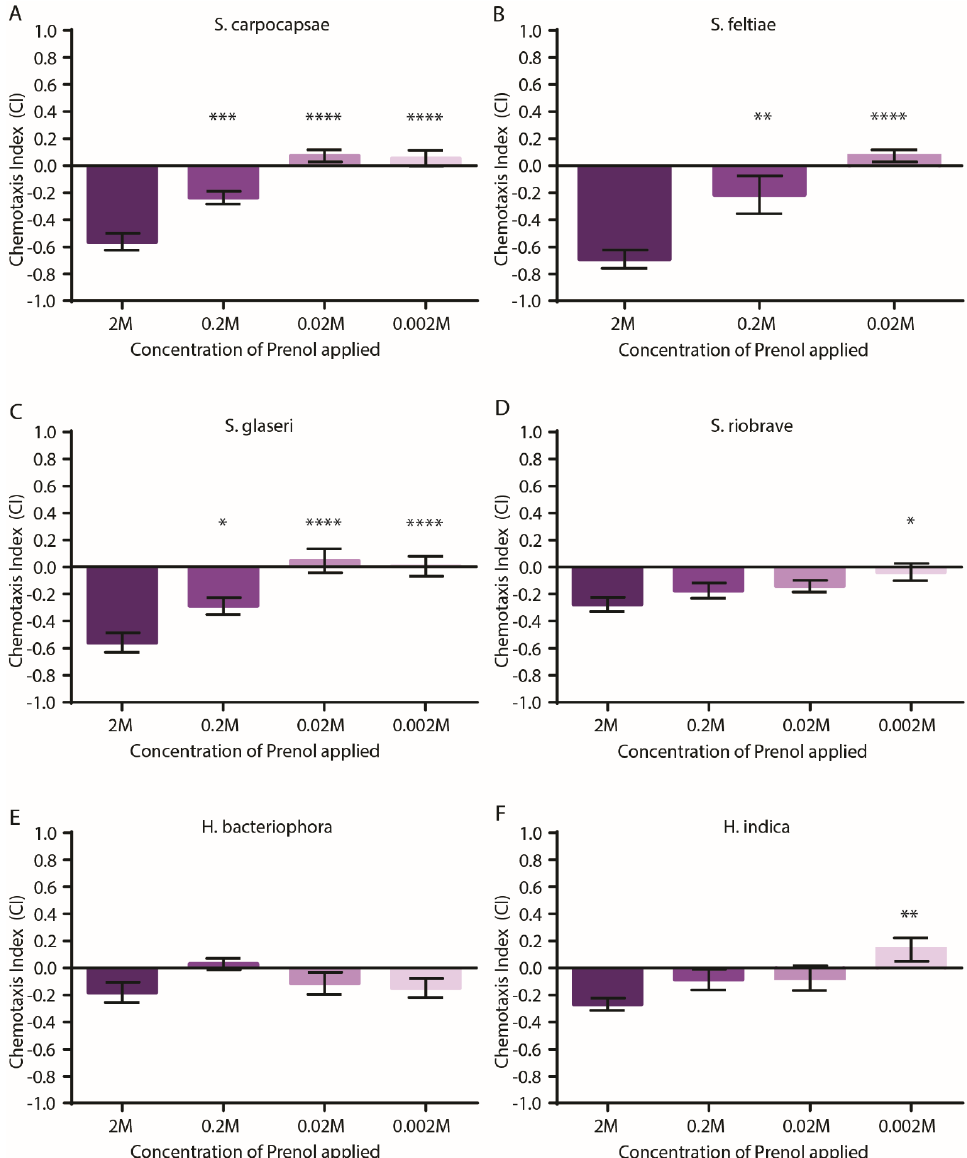
Figure 2. Responses of the entomopathogenic nematode (EPN) infective juveniles (IJs) to varying doses of prenol in the PF127 media chemotaxis assay. For the chemotaxis index (CI) values, a score near − 1 indicates a high aversion, near 0 indicates neutrality, and +1 indicates a strong attraction. The concentrations listed along the x axis (of all graphs) represent the initial concentration of the compound applied to the plate (5 µL applied to the test region and 5 µL of diluent (ethanol) applied to the control region). Chemotaxis responses by ( A ) S. carpocapsae , ( B ) S. feltiae , ( C ) S. glaseri , ( D ) S. riobrave , ( E ) H. bacteriophora , and ( F ) H. indica. Bars represent the mean with error bars representing SEM. For all the graphs, a one-way ANOVA with Dunnett’s multiple comparisons post-test (comparing the value for the response to 2 M to all other concentrations tested) was used. * p < 0.05, ** p < 0.01, *** p < 0.001; **** p < 0.0001. Experiments consisted of 4 plates for an experiment, with 3 biological replicates.